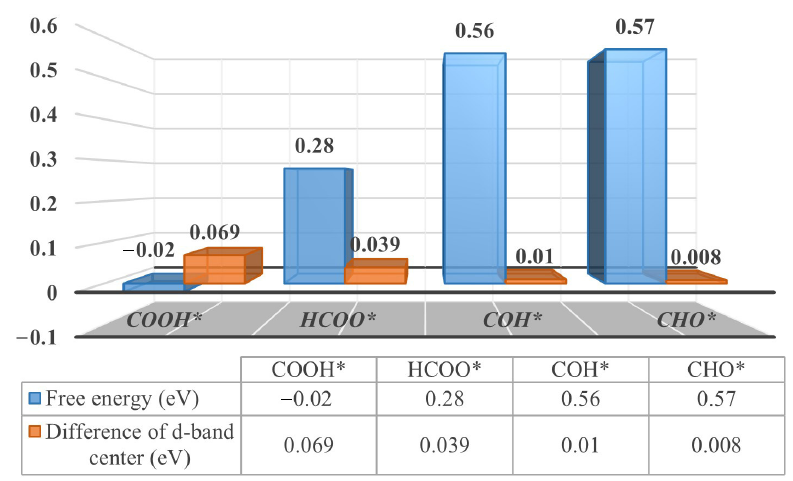
Figure 5. The formation free energy (eV) and d-band center difference (absolute value, eV) for adsorption of specific intermediates on Pd 3 Au (110) surfaces.